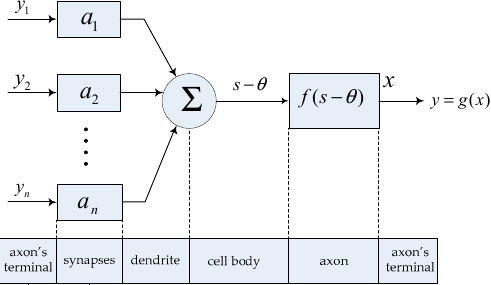
Figure 3. The signal transmission model of the neuron.